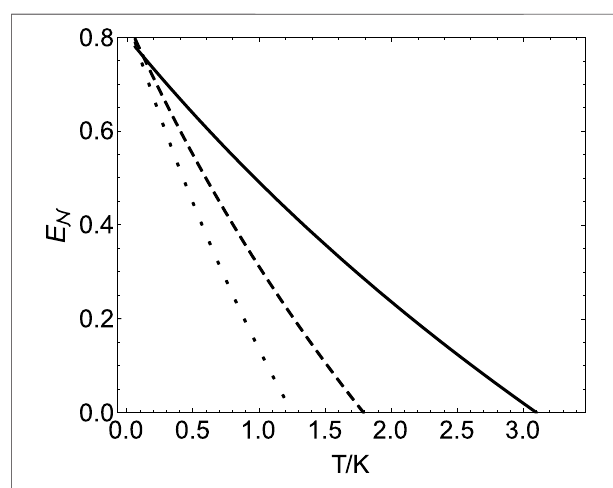
FIGURE 5 | Logarithmic negativity E N as a function of the temperature for different masses of oscillators. The solid line refers to m (cid:1) 5 p 10 − 9 kg, the mass corresponding to the dash line is m (cid:1) 10 p 10 − 9 kg, and for the dotted line m (cid:1) 15 p 10 − 9 kg. The normalization detuning is Δ / ω m = 1.